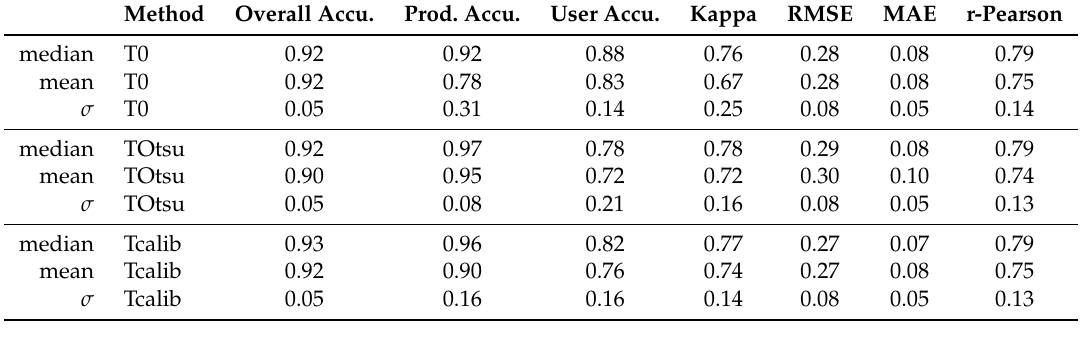
Table 4. Accuracy and error metrics for three MNDWI classification methods on multi-sensor imagery (Landsat 7, Landsat 8, Sentinel-2 and MODIS) over the 2017 and 2019 floods.